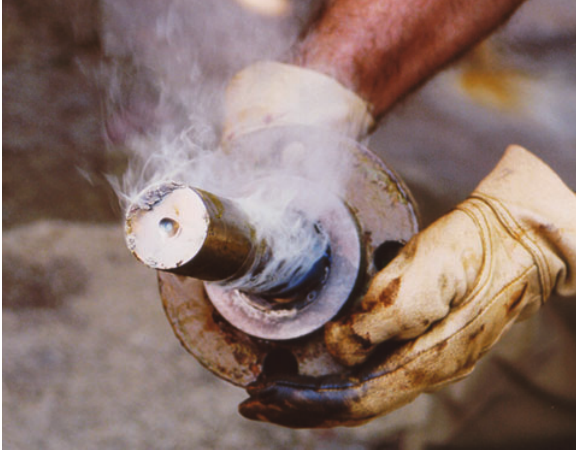
Figure 1 PAT tools enable the successful transfer of processes from lab to